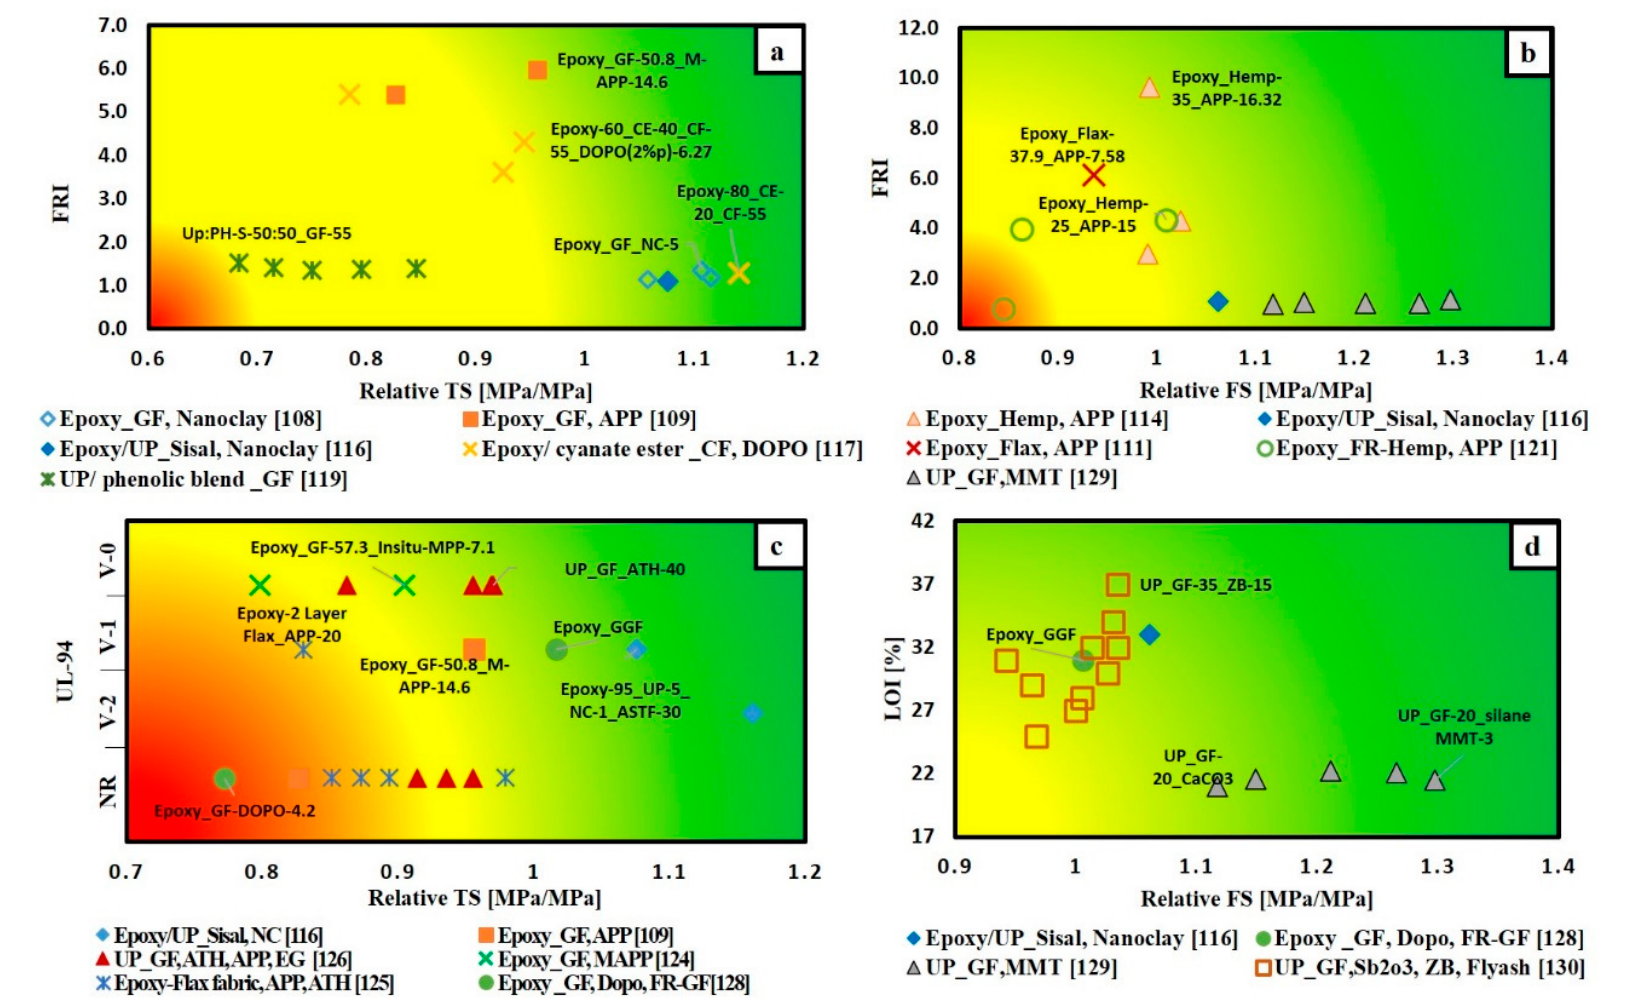
Figure 14. Selection charts of FR type regarding the desired flame retardance level and the mechanical property for epoxy and unsaturated polyester composites ( a ) FRI versus relative TS; ( b )FRI versus relative FS; ( c ) UL-94 versus relative TS; ( d ) LOI versus relative FS.